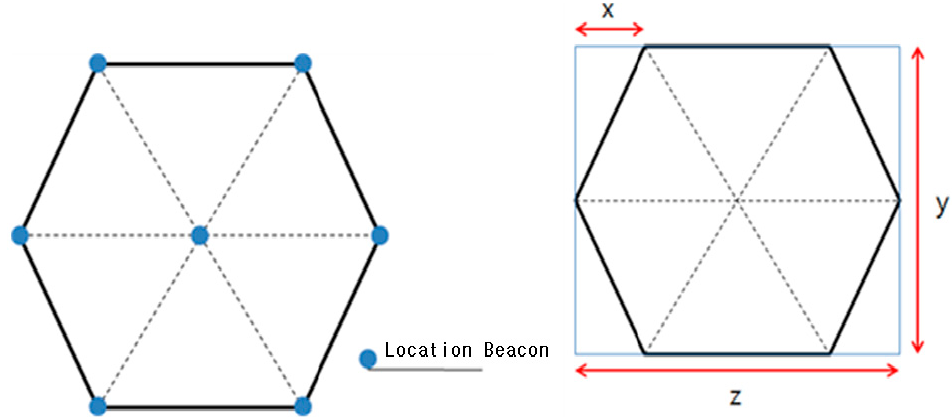
Figure 1. A basic Unit Space with Beacons.